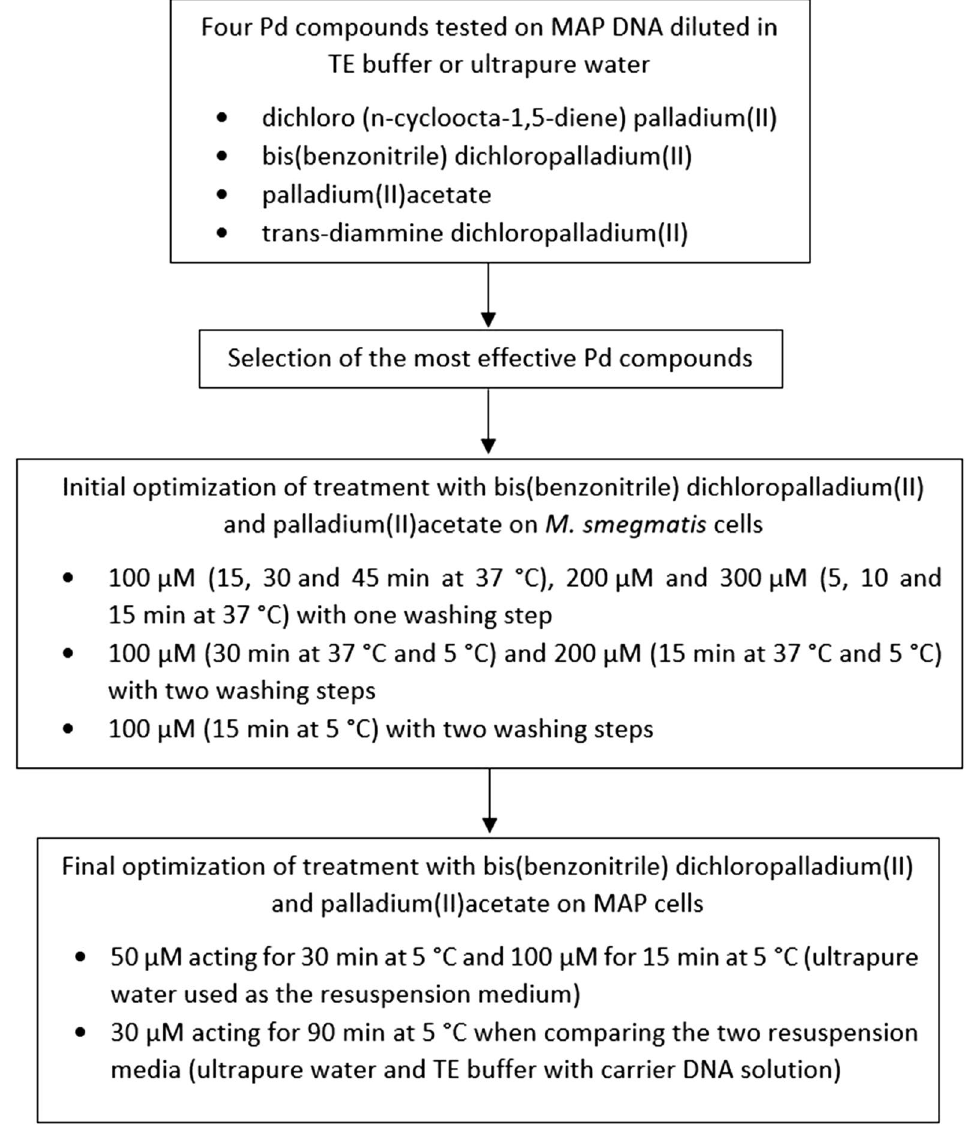
Figure 1. Schematic overview of the optimization of Pd compound